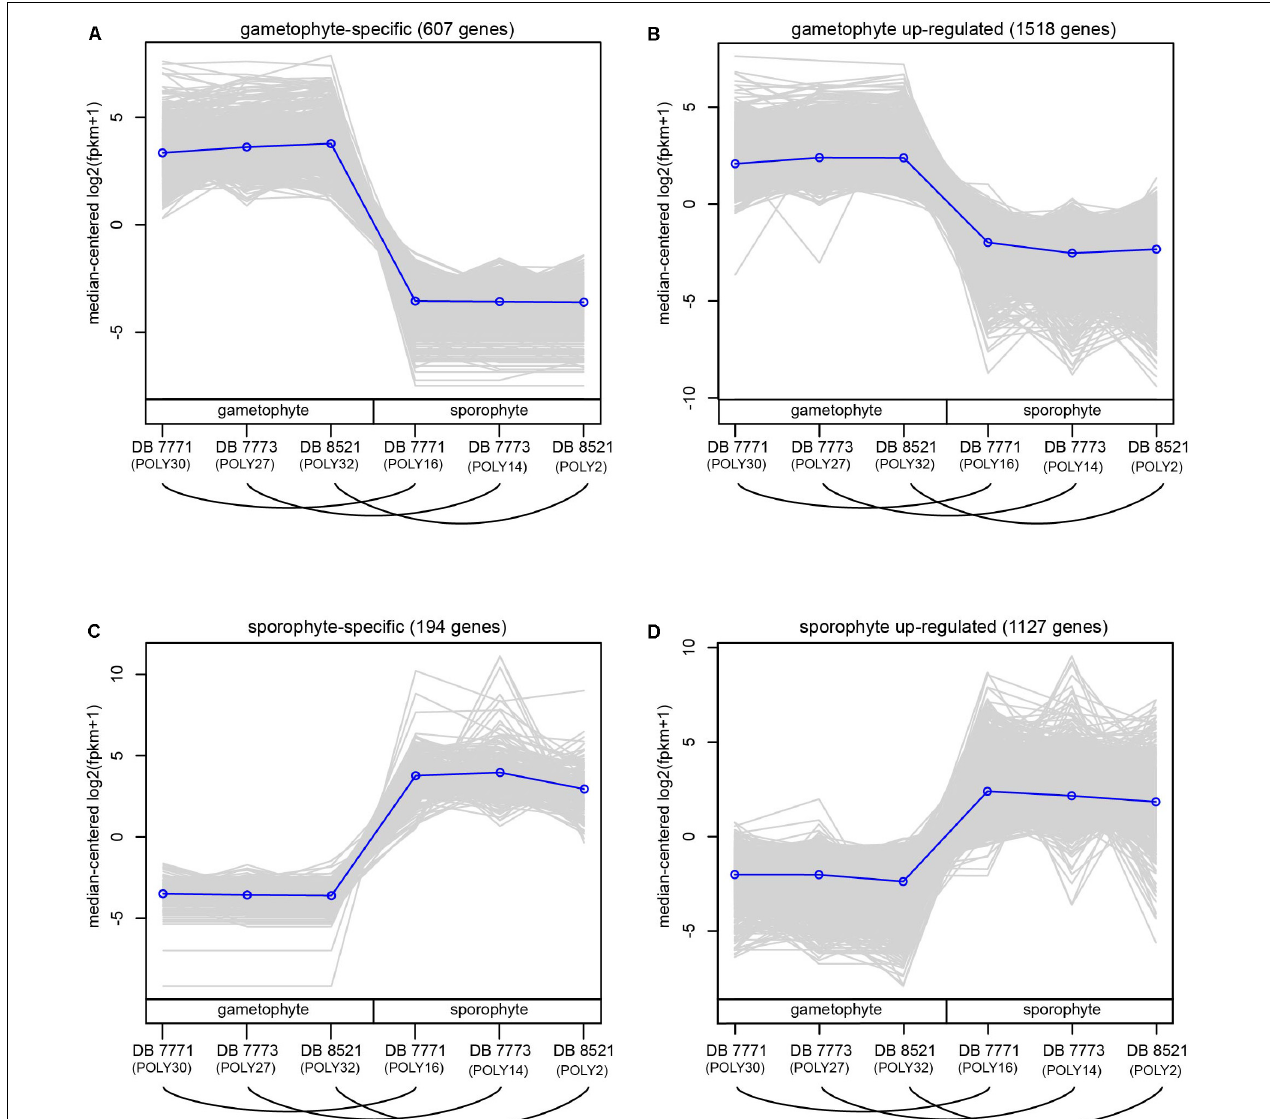
FIGURE 4 | Normalized expression (log2-transformed FPKM + 1) of genes assigned to four categories of differential expression using the criteria of log2FC ≥ 2 and padj ≤ 0.002. Each gray line represents the expression level of a particular gene relative to the median expression level of all genes in that expression category. Blue lines represent the median expression level for each expression category. Samples are labeled as gametophyte or sporophyte, with an arched line connecting samples derived from the same Polypodium amorphum individual. (A) gametophyte-specific genes; (B) gametophyte up-regulated genes; (C) sporophyte-specific genes; (D) sporophyte up-regulated